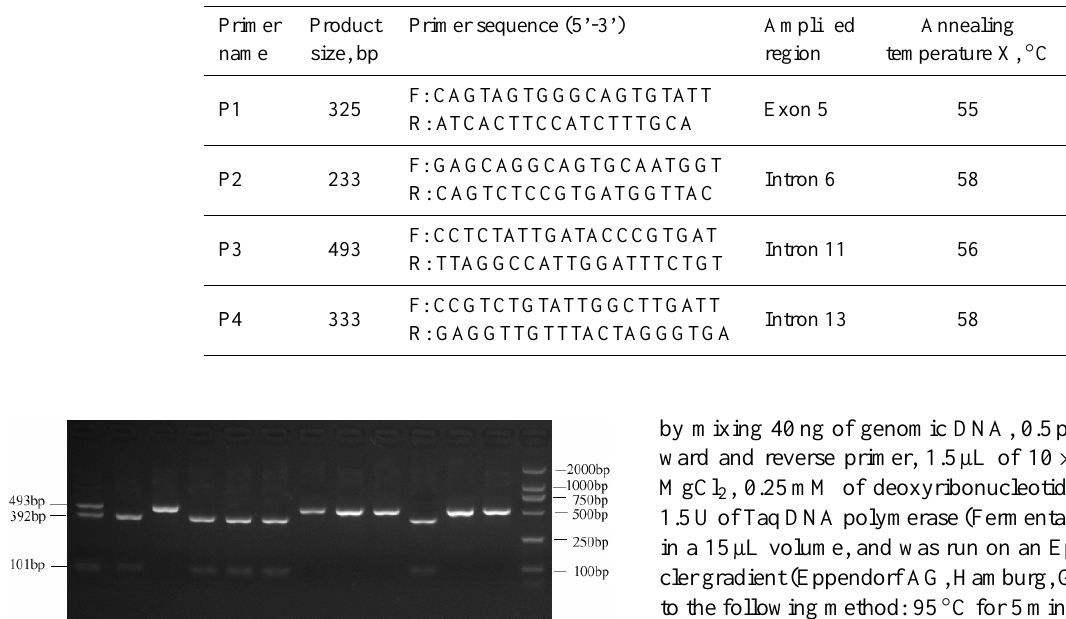
Table 1. Primer sequence, product size and annealing temperatures used in analyses of quail VLDLR gene.